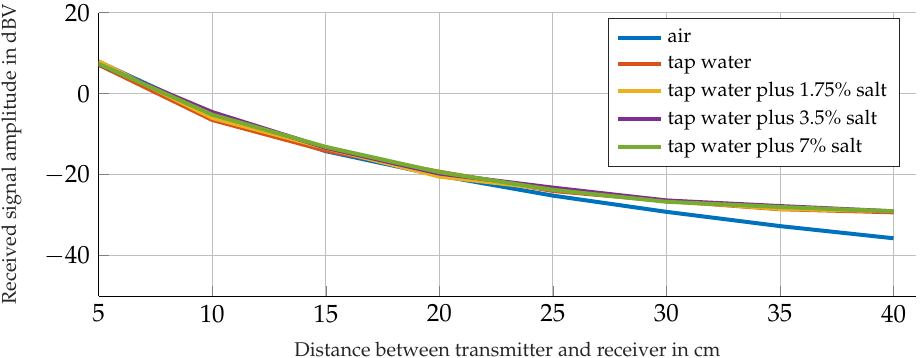
Figure 2. Receiver signal amplitudes for different propagation media and receiver–transmitter distances